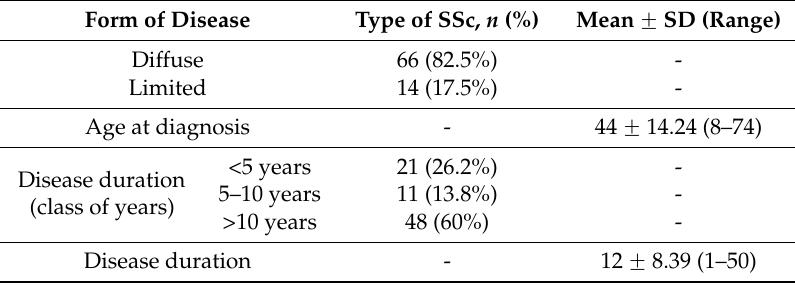
Table 2. Form of disease of SSc